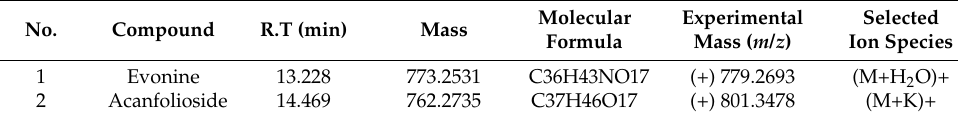
Molecular Experimental Formula Mass ( m / z